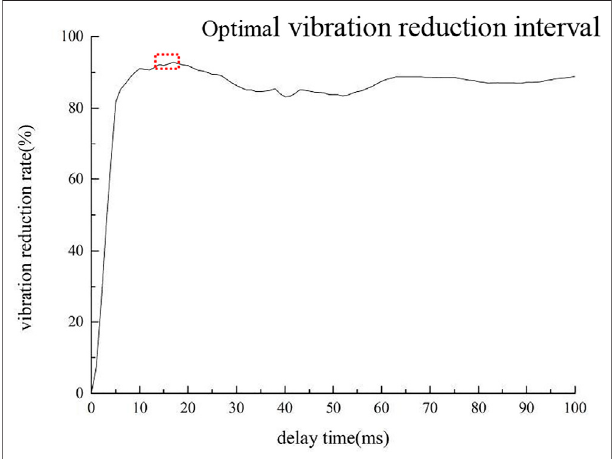
FIGURE 6 | Relationship curve between delay time and vibration reduction